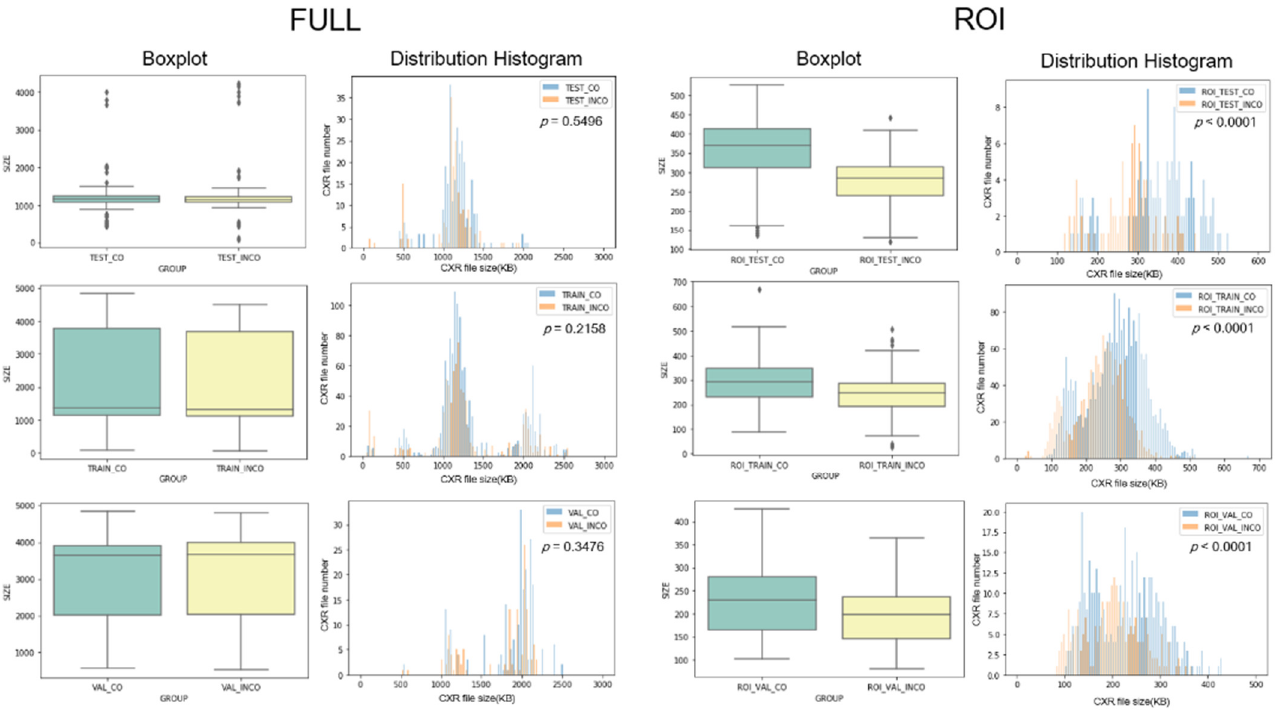
Figure 3. Boxplot and distribution histograms of CXR file size in the three subgroups of the FULL and ROI groups.